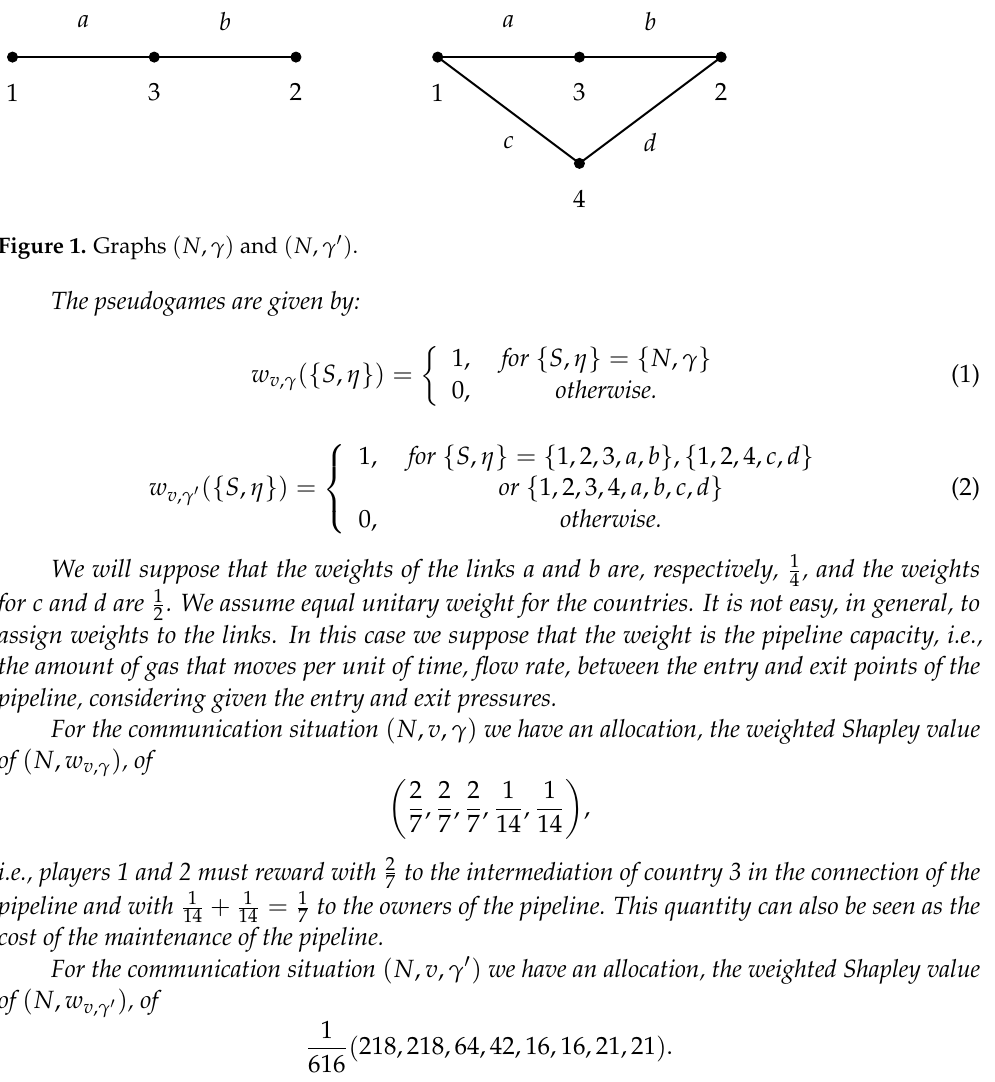
Figure 1. Graphs ( N , γ ) and ( N , γ (cid:48) )